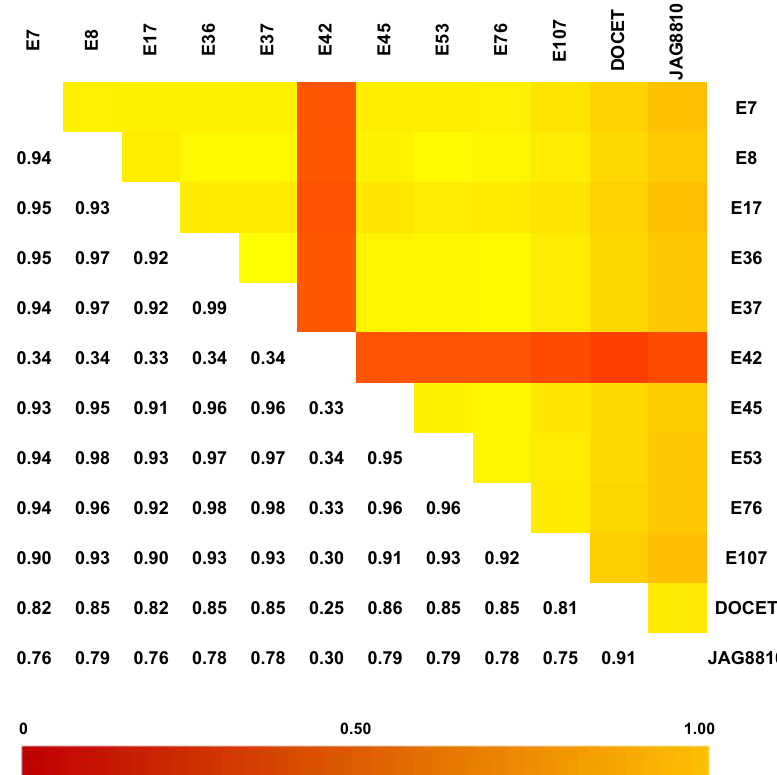
Figure 3. Identity-by-state (IBS) distance heat matrix among the 12 genotypes considering the dataset of 22,594 SNPs. In each pairwise comparison, values near 1 (yellow color) indicate low genetic distance whereas values near 0 (red color) represent high genetic distance.